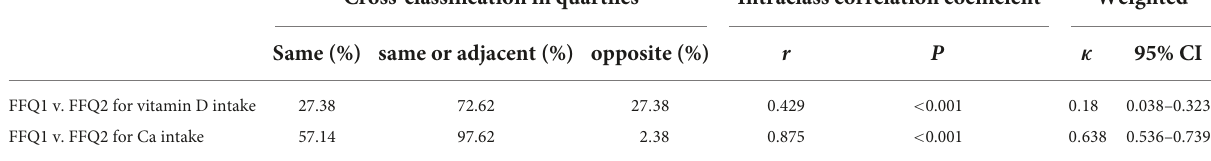
TABLE 4 Cross-classification into quartiles and reliability of the FFQ (Intraclass correlation coefficient) ( n = 84). Cross-classification in quartiles Intraclass correlation coefficient Weighted